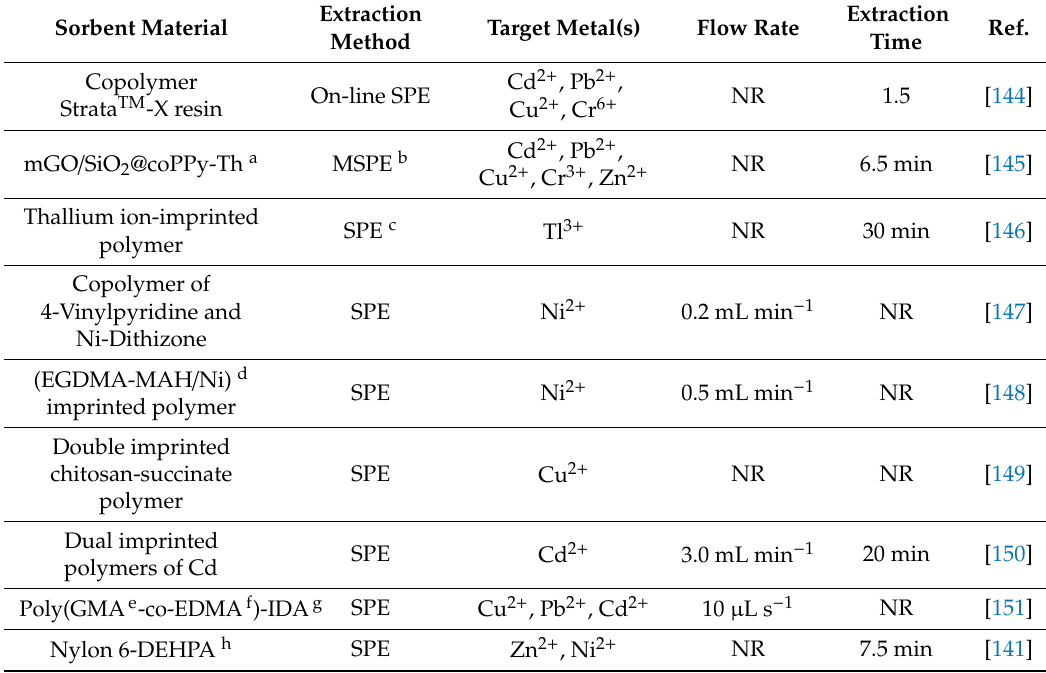
Table 5. Polymer-based sorbent materials for metal ion